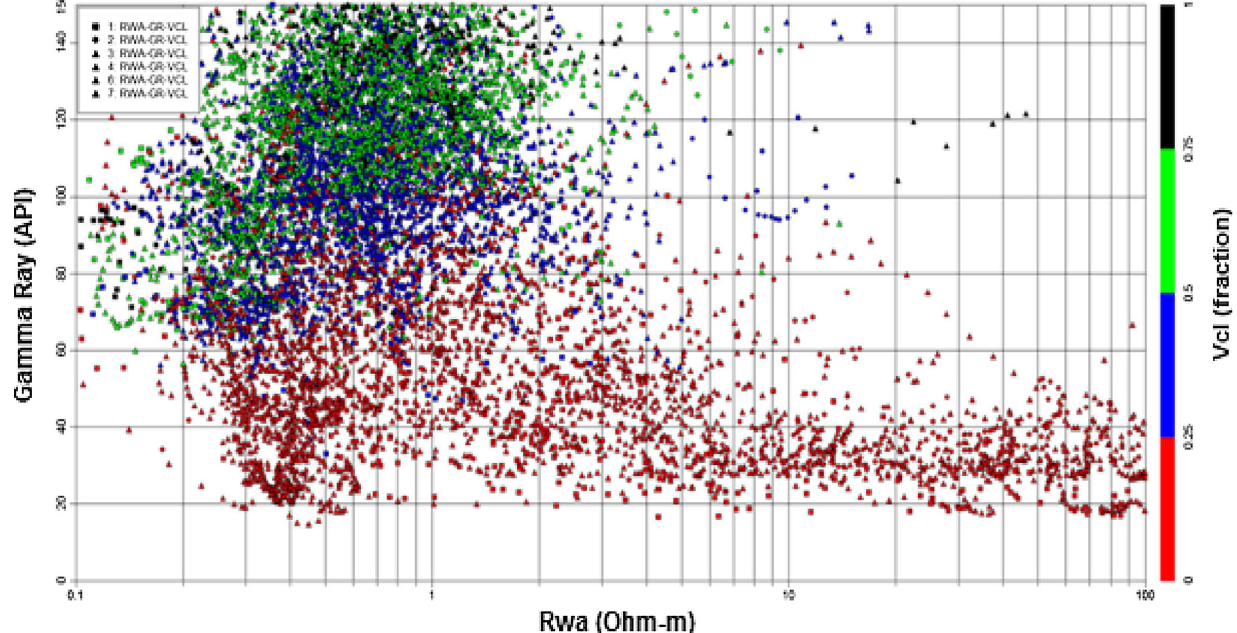
Fig. 15 Multi-well GR versus RWA plot to determine R